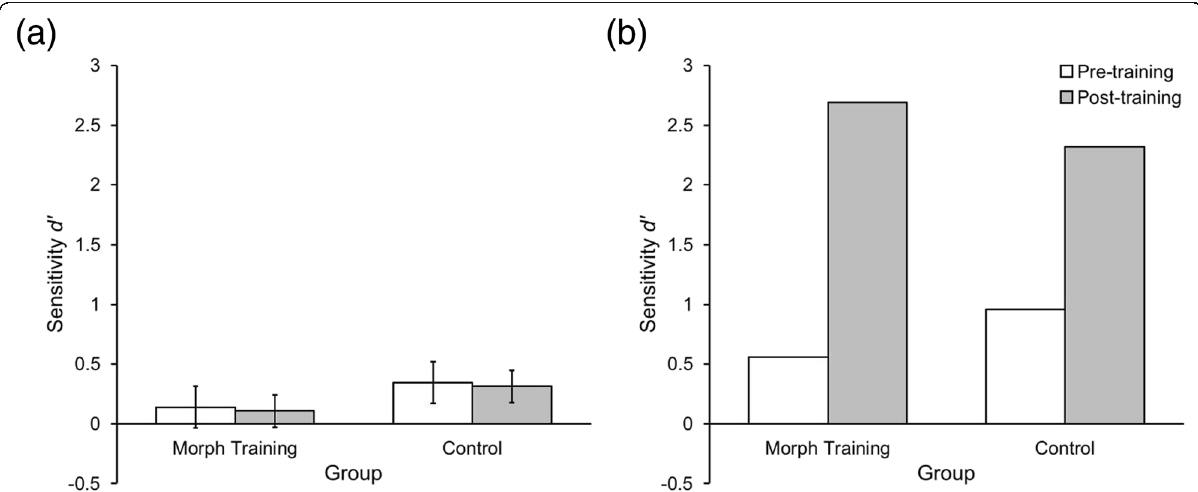
Fig. 2 A comparison of Experiment 1 and previous work. A plot of sensitivity data from ( a ) the current experiment and ( b ) Robertson et al. (2018), displayed on the same axes. Data in ( b ) display the results of Robertson ’ s 50% morphs only. Error bars represent 95% confidence